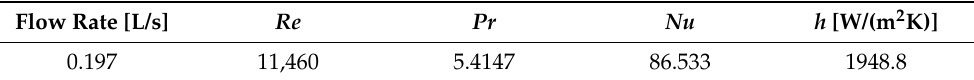
Table 1. Values of volume flow rate, of Re , Pr , and Nu numbers, and of the convection coefficient. Flow Rate [L/s]